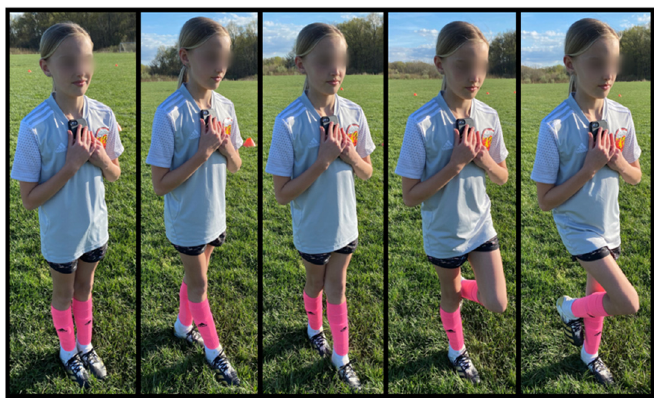
Figure 2. SWAY Balance stances from left to right: Feet together, tandem right, tandem left, single-leg right, and single-leg left. Table 1. Get aHEAD Safely in Soccer™ neck and core strengthening exercise progression.